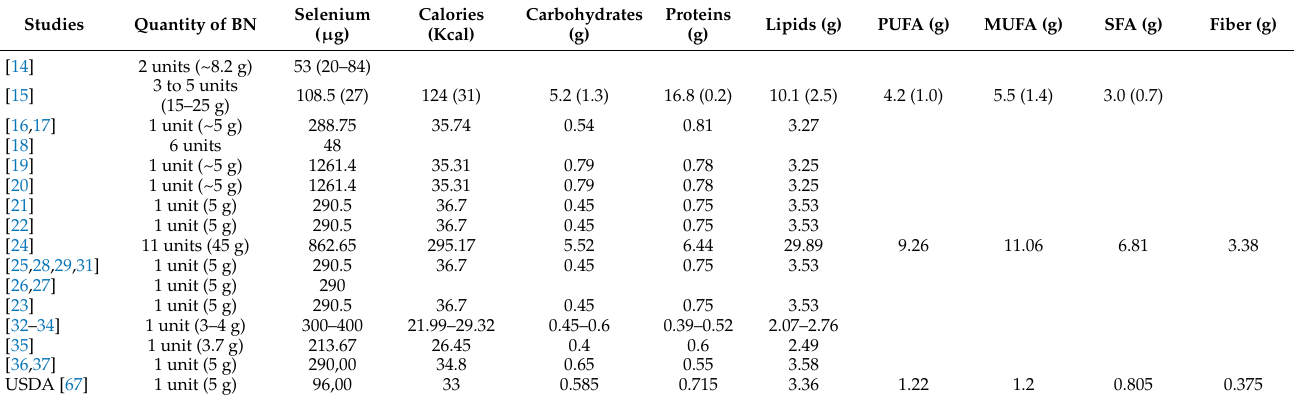
Table A2. Brazil nut composition of studies included in the systematic